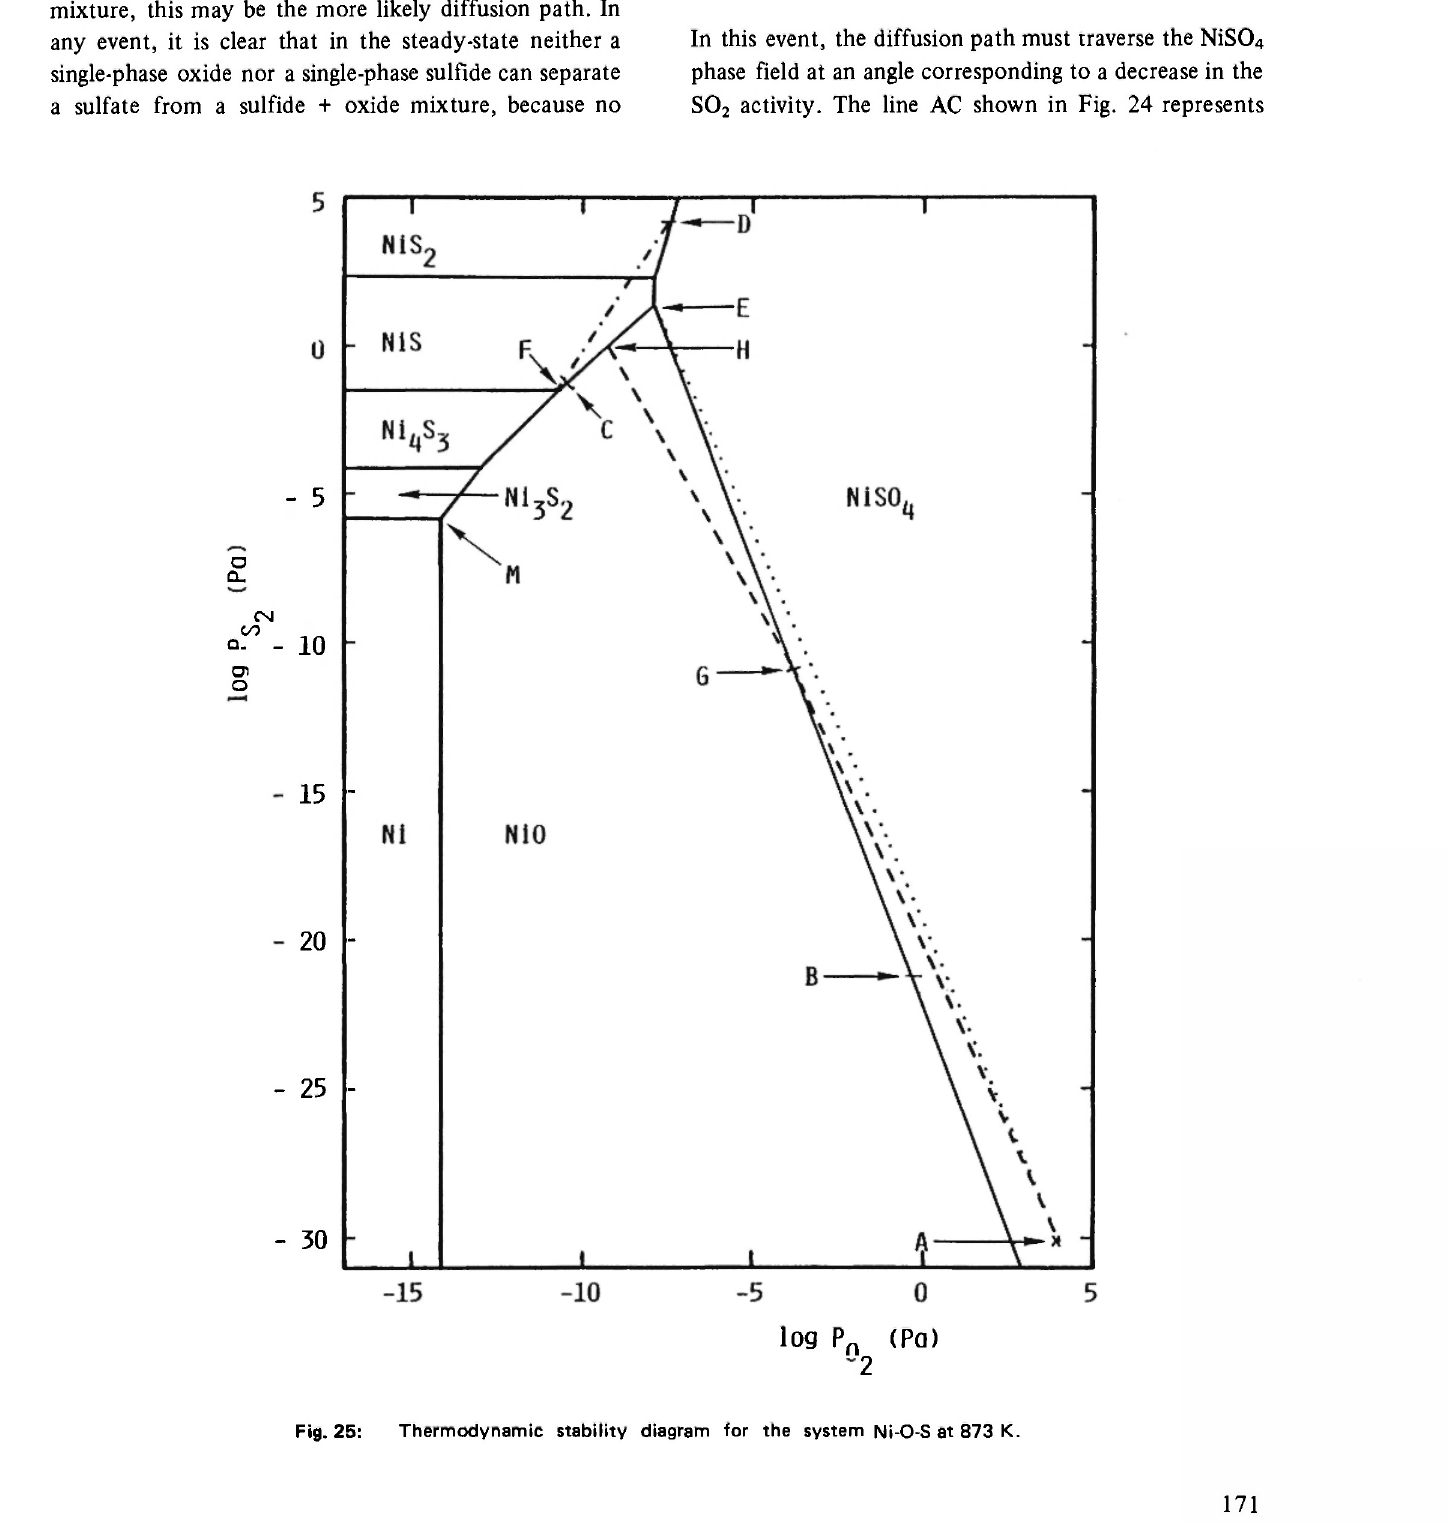
Fig. 25: Thermodynamic stability diagram for the system Ni-O-S at 873